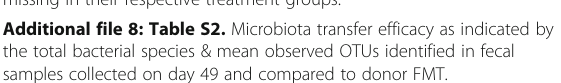
Additional file 6: Figure S6. High-fiber diet composition by manufacturer. Additional file 7: Table S1. Bacterial taxa in donor FMTs that are missing in their respective treatment groups. Additional file 8: Table S2. Microbiota transfer efficacy as indicated by the total bacterial species & mean observed OTUs identified in fecal samples collected on day 49 and compared to donor